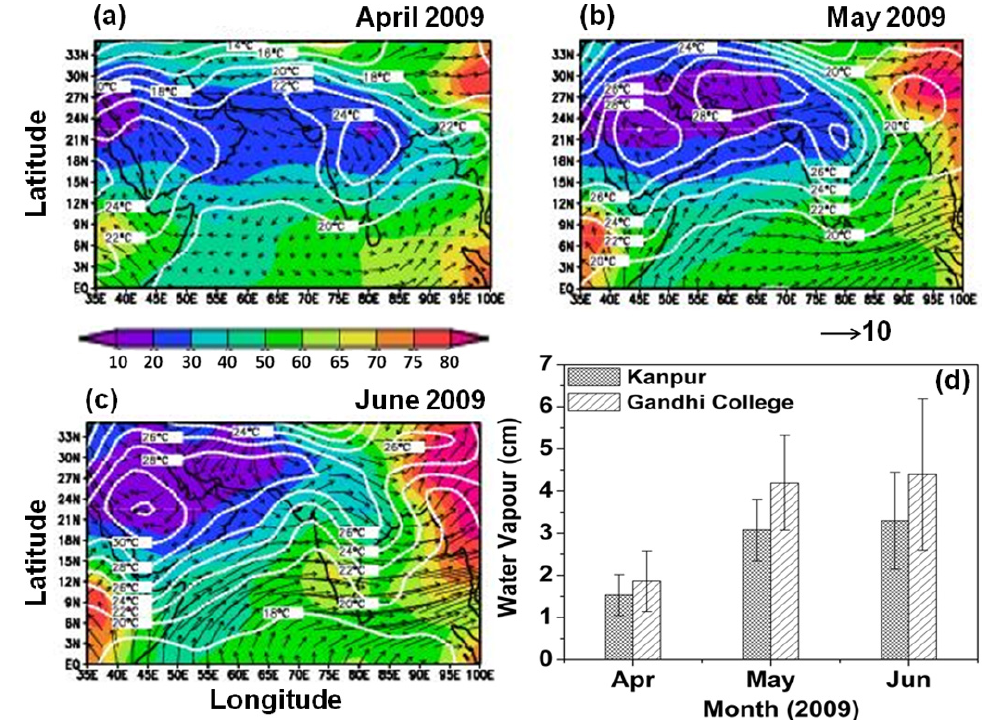
Fig. 2. Synoptic meteorological conditions over the entire IGB region along with the other parts of India and its surroundings during (a) April 2009, (b) May 2009, (c) June 2009 at 850hPa level and (d) sun photometer retrieved columnar water vapor at Kanpur and Gandhi College during April to June